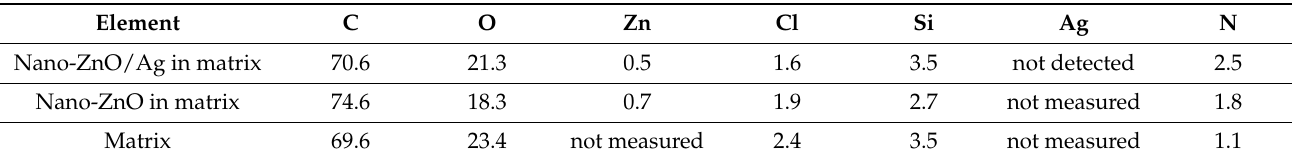
Table 1. Atomic concentration of elements in nano-ZnO- and nano-ZnO/Ag-containing coatings and in pure matrix material on plywood substrates according to XPS